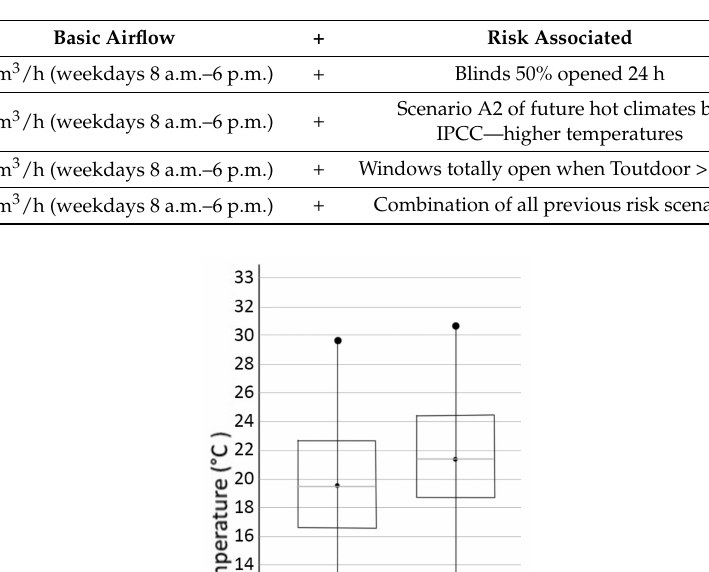
Table 4. Risk scenarios analysed.